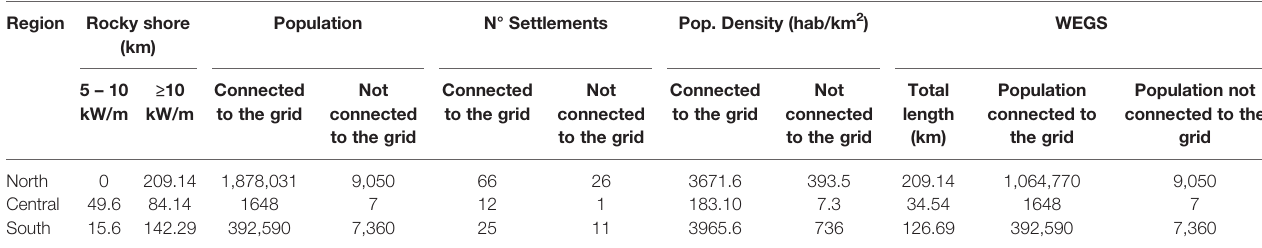
TABLE 2 | Main characteristics of coastal sites and the identi fi ed WEGS. Region Rocky shore